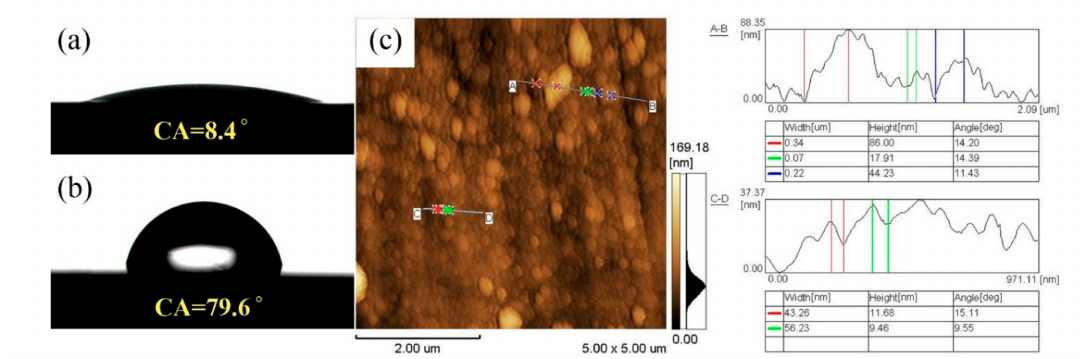
Figure 2. The contact angles of the ( a ) MgZn substrate, ( b ) TiO 2 coating, and ( c ) the AFM micrograph of the TiO 2